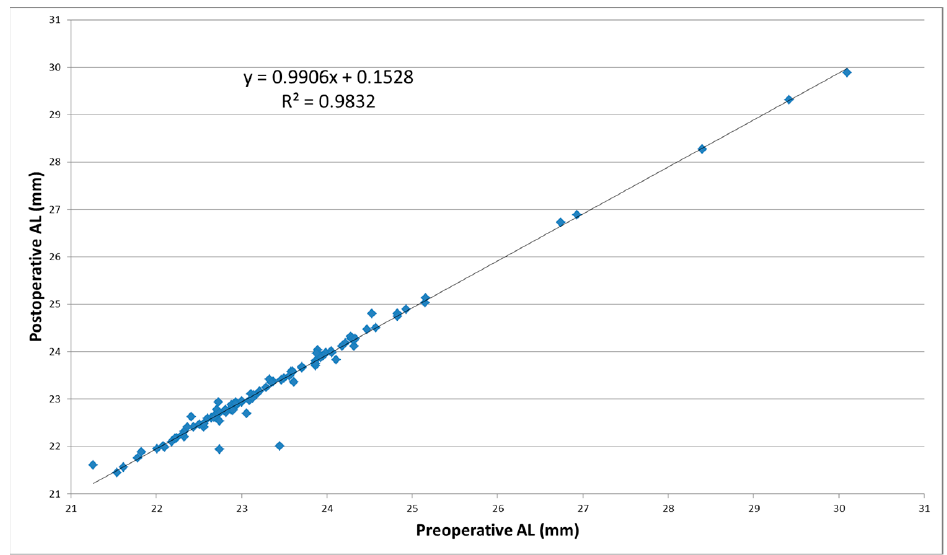
Figure 2. Correlation between the postoperative and preoperative AL values.